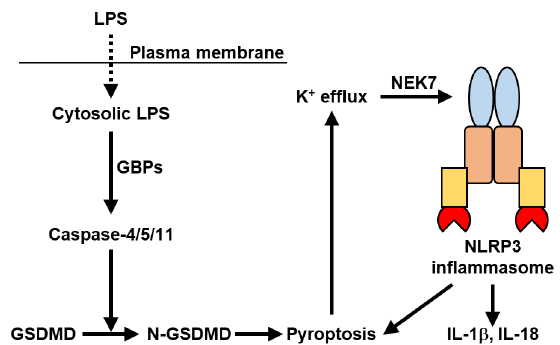
Figure 3. Mechanism of non-canonical NLRP3 inflammasome activation. Caspase-4/5/11 sense cytosolic lipopolysaccharide (LPS) from Gram-negative bacteria. Guanylate-binding proteins (GBPs) bind to cytosolic LPS and are implicated in the activation of the caspases. Active caspase-4/5/11 directly cleave GSDMD independently of caspase-1. Cleaved N-terminal fragments of GSDMD (N-GSDMD) induce pyroptosis, which triggers K + efflux and activation of the non-canonical NLRP3 inflammasome. Activated caspase-1 induces IL-1β and IL-18 maturation and promotes pyroptosis. NEK7 is required for the non-canonical NLRP3 inflammasome downstream of K + efflux.